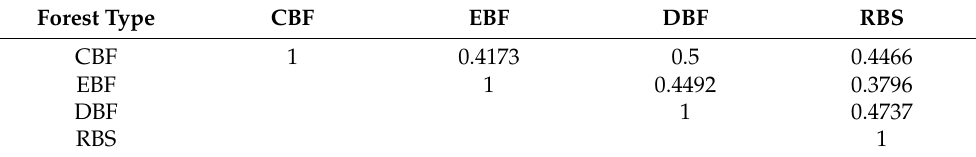
Table 5. Distributions of genera numbers and individual numbers of soil mites in the study area. Forest Type CBF EBF DBF RBS CBF 1 0.4173 0.5 EBF 1 DBF RBS